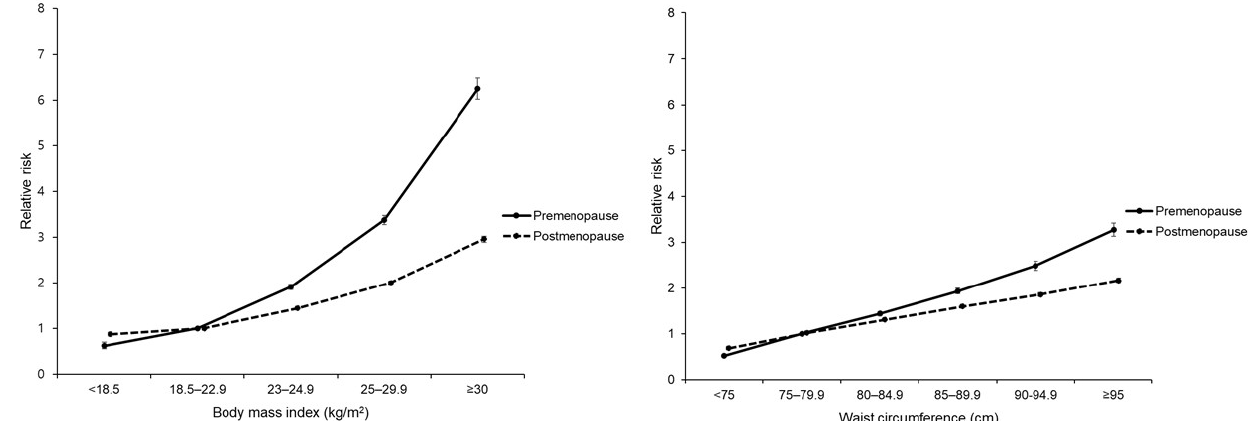
Figure 2. Diabetes incidence according to (A) body mass index and (B) waist circumference by menopausal status.